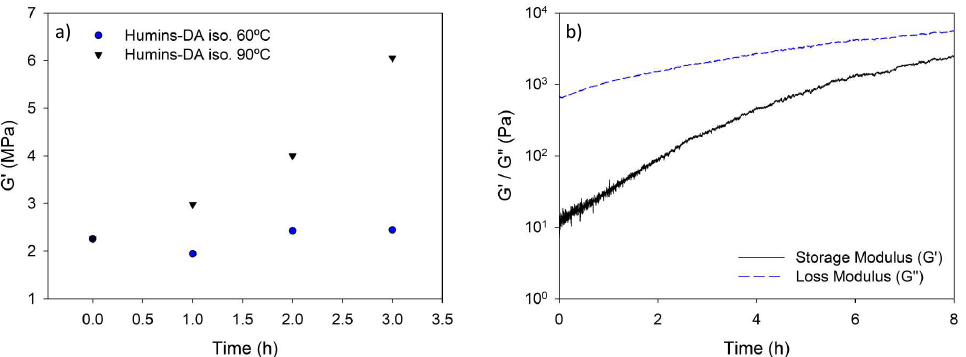
Figure 4. Isothermal small amplitude oscillatory time sweeps at 60 °C for ( a ) Humins-DA and ( b ) humins. Both tests were performed at a frequency of 1 Hz and an amplitude of 1%.